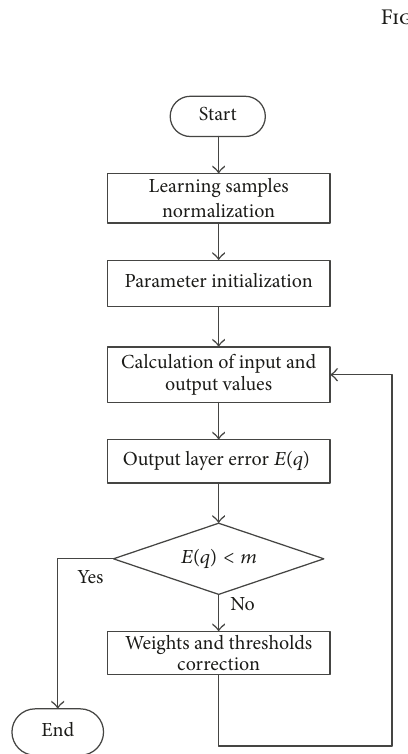
Figure 8: Calculation procedure of the BP network